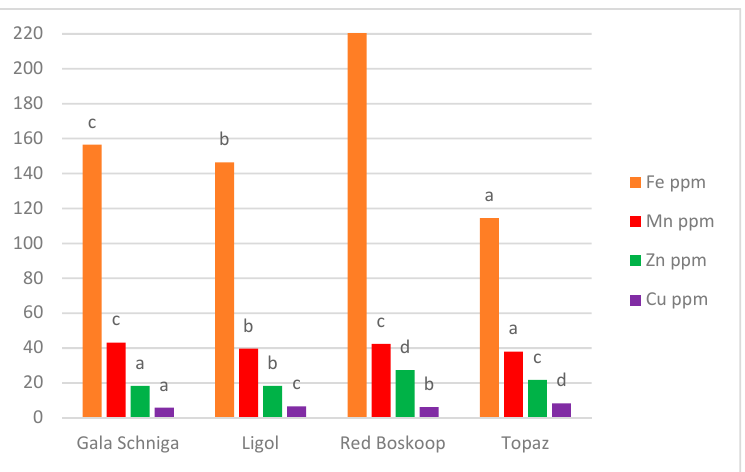
Figure 4. A comparison of the content of micronutrients in leaves of maiden apple trees depending on the variety used. Data followed by the same letters do not differ significantly at p = 0.05 for each micronutrient according to Tukey’s test.